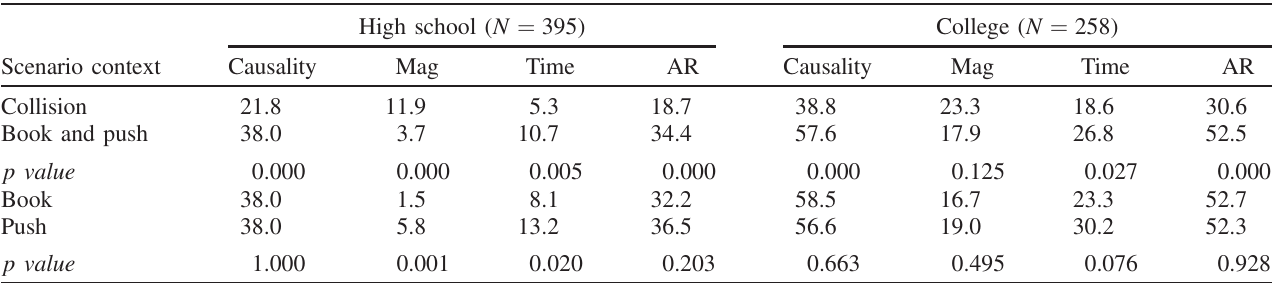
TABLE II. Percentages of high school and college students who responded with choice 1 on the four attributes of causal reasoning in different scenario contexts. Book and push represents the average percentage of responses to the book and push question. The p value indicates the statistical significance of the difference between the